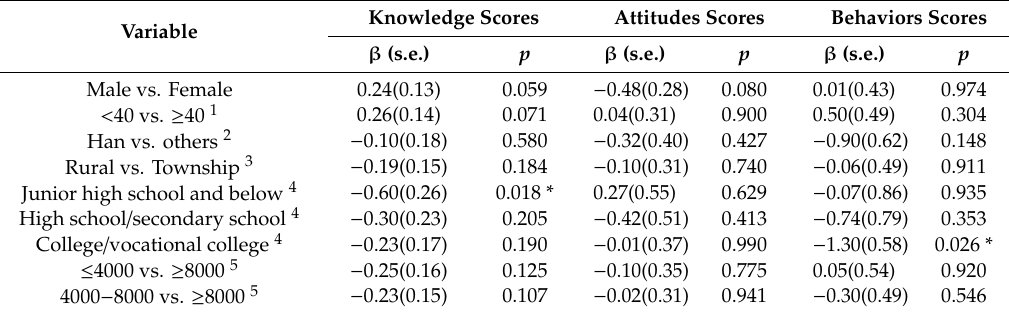
Table 4. Multivariate analysis of KAP risk factors related to food safety ( n = 361). Variable